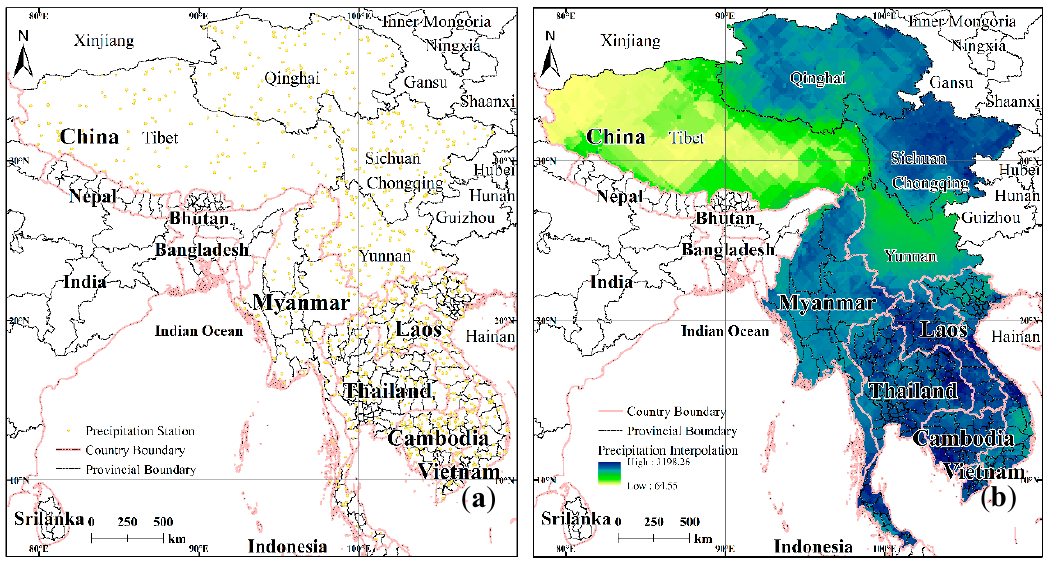
Figure 2. Distribution of sites ( a ) and precipitation ( b ) in the LMR.